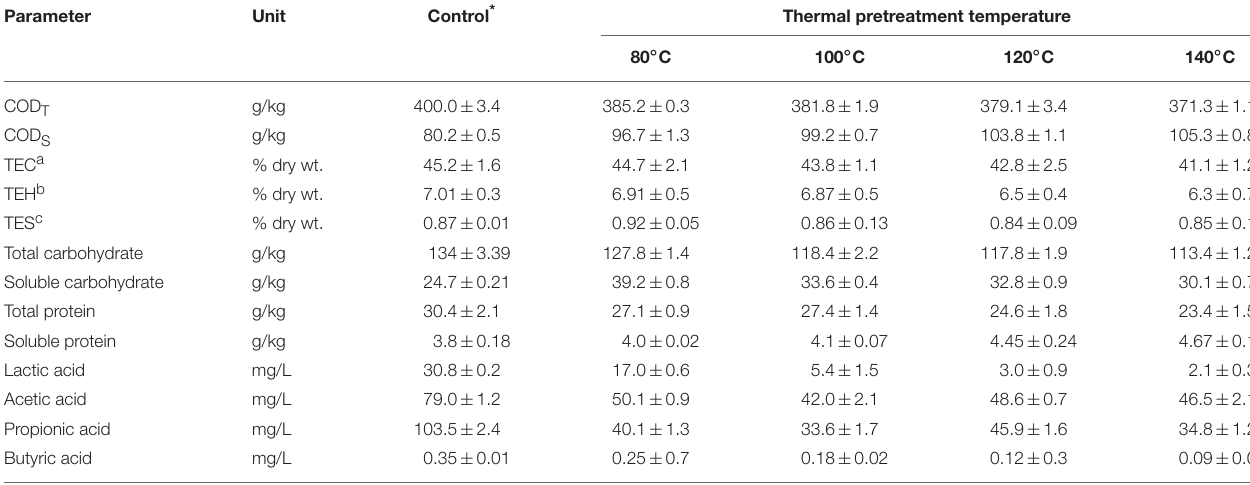
TABLE 3 | Chemical composition of FW before and after each TP. Parameter